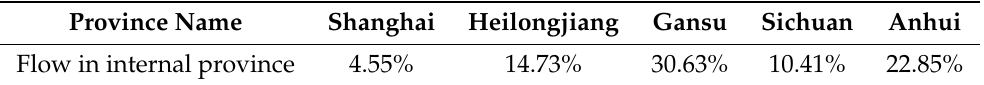
Table 4. The proportion of the passenger flow in internal circulation in five provinces.